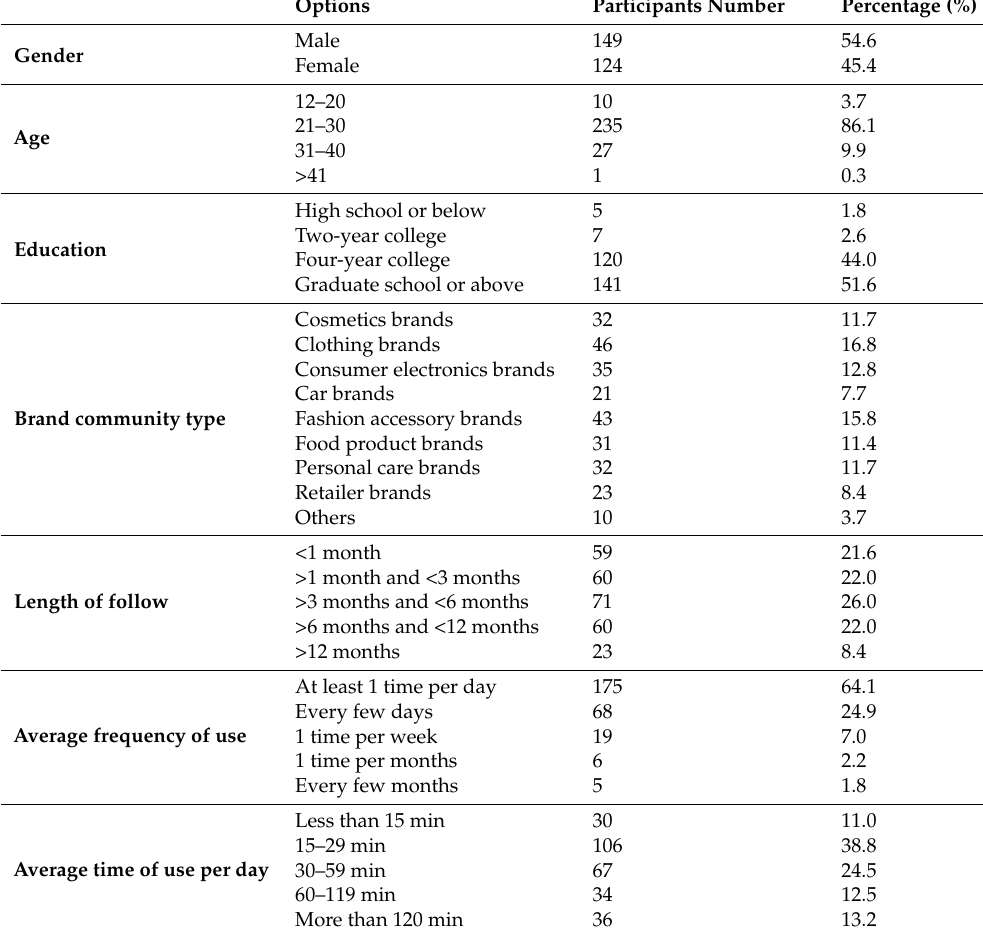
Table 1. Of the research